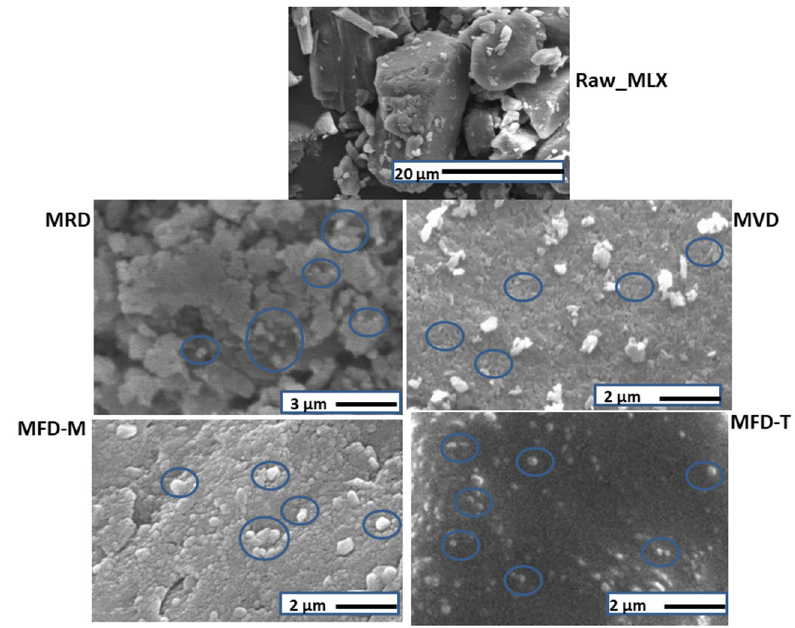
Figure 1. SEM images of MLX-related samples of raw MLX, MRD, MVD, MFD-M, and MFD-T.